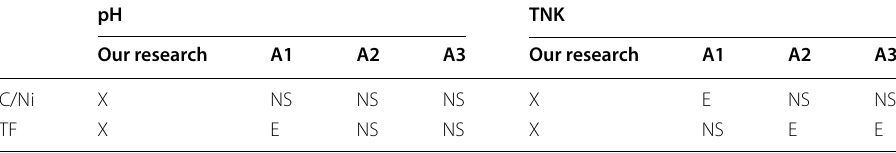
Table 17 Summary of C/Ni and TF effects on pH and TNK according to several authors